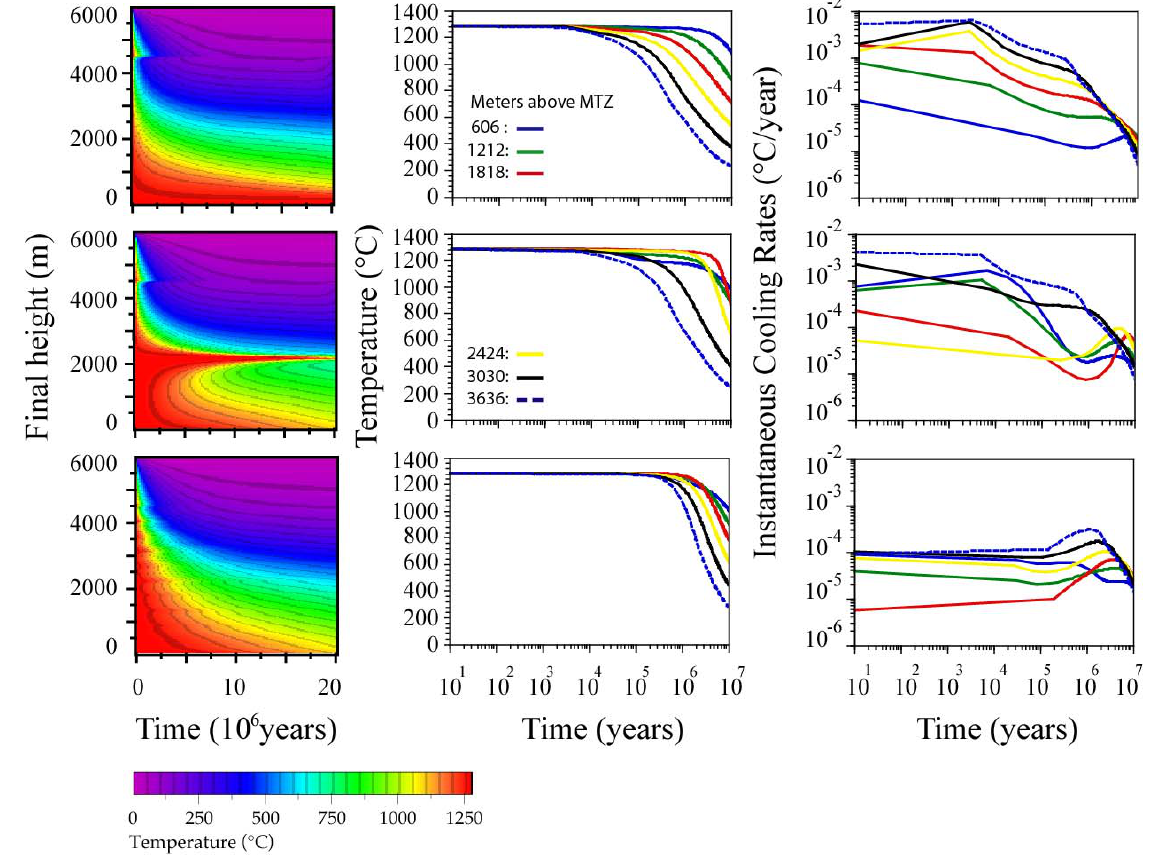
Fig. 5. Thermal history of the gabbro versus their final height above MTZ in the cooled lower crust and the G (top panels), M (middle) and S (bottom) crustal accretion modes. Left panels display the T (t) evolution of Lagrangian tracers along their trajectories in the lower crust; middle panels give this temperature evolution for different depths (given in height above MTZ in panels); evolutions of the instantaneous cooling rates are given in the right panels. The results have been obtained with T crac = 700 ◦